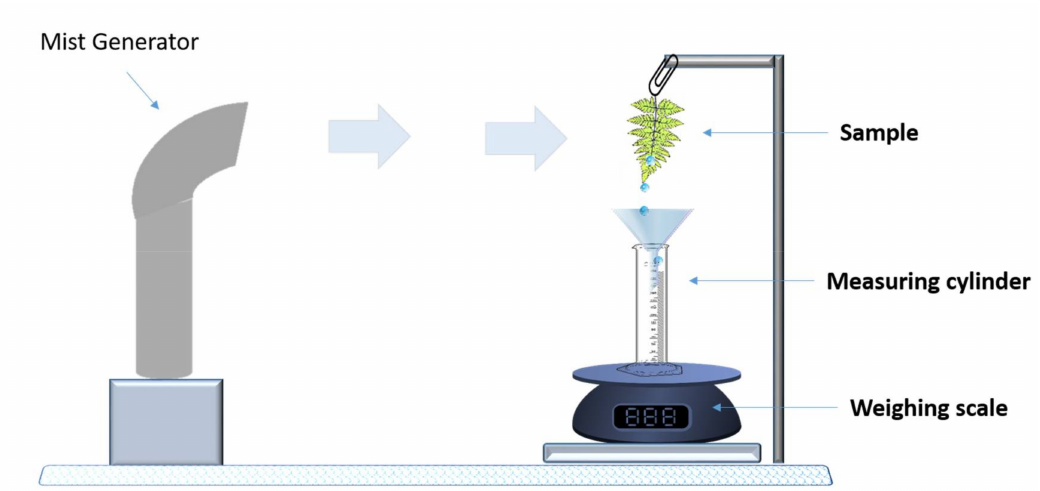
Figure 1. Schematic of the experimental setup for water